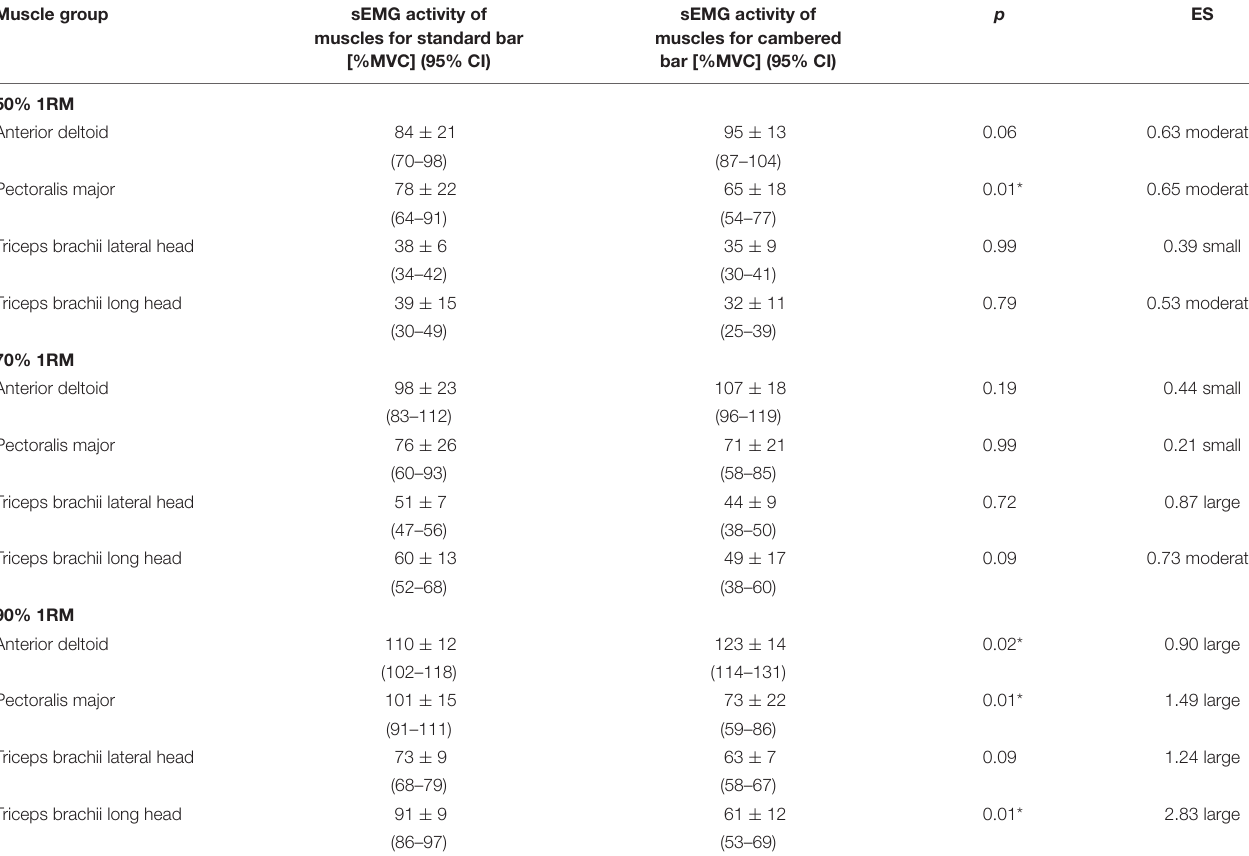
TABLE 1 | The sEMG activity of muscles during the bench press exercises with standard and cambered bar and different external loads. Muscle group